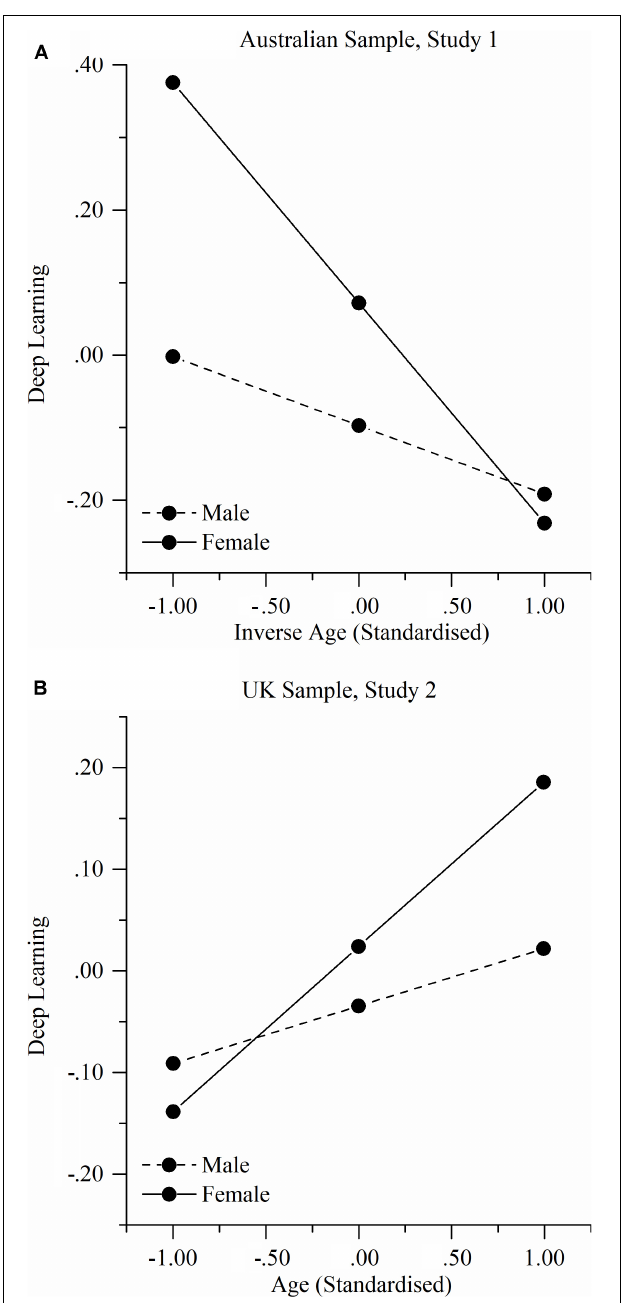
FIGURE 2 | The interactive effect of age and gender on deep learning. (A) Displays the results for the Australian sample, and (B) illustrates the results for the United Kingdom sample.